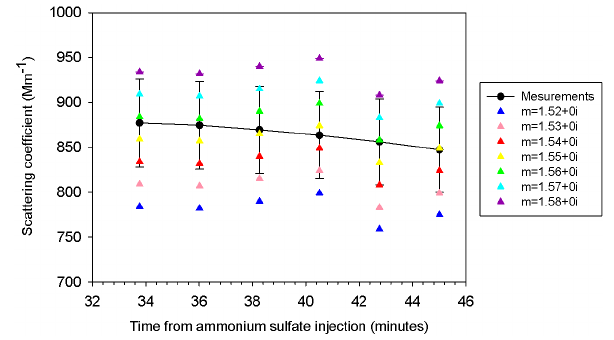
Fig. 5. Measured and calculated scattering coefficient using Mie scattering calculations for different CRI.